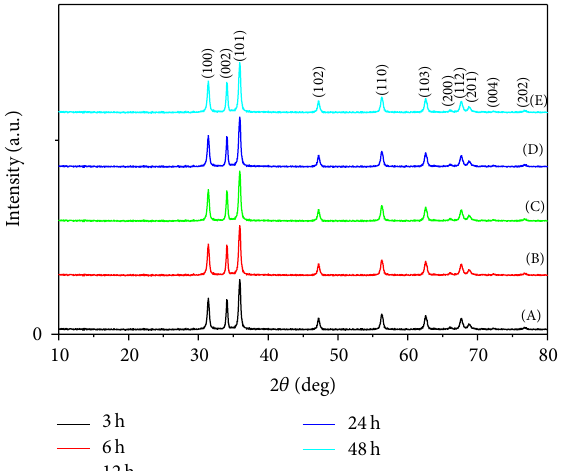
Figure 13: XRD patterns for ZnO nanopowders via hydrothermal technique with different reaction times: (A) 3 h, (B) 6 h, (C) 12 h, (D) 24 h, and (E) 48 h.